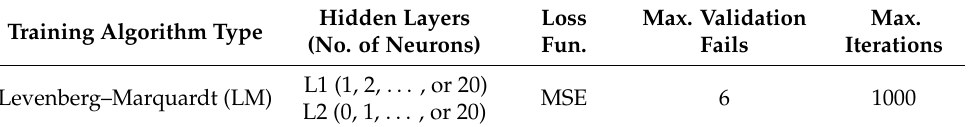
Table 2. Configuration of the ANN models used in the study, including the training algorithm, numbers of hidden layers and neurons, loss function, maximum number of validation fails, and maximum number of iterations. Training Algorithm Type